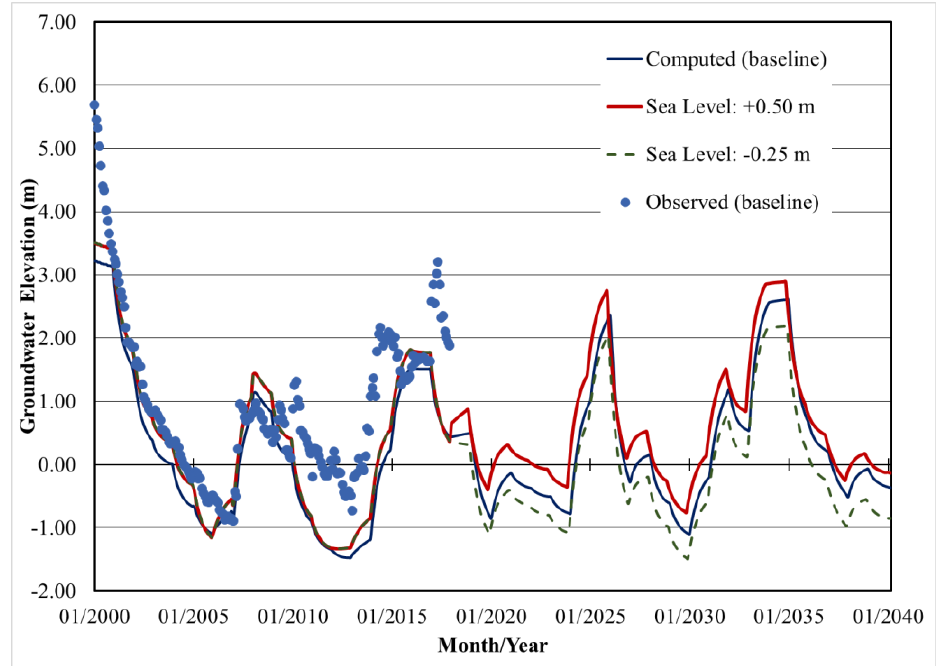
Figure 9. Groundwater elevations in Wadi Al-Jizi aquifer (Station EA1) in response to sea level rise until 2040. The existing observed elevations (2000 to 2017) along with the computed values from MODFLOW are shown from 2000 to 2040.